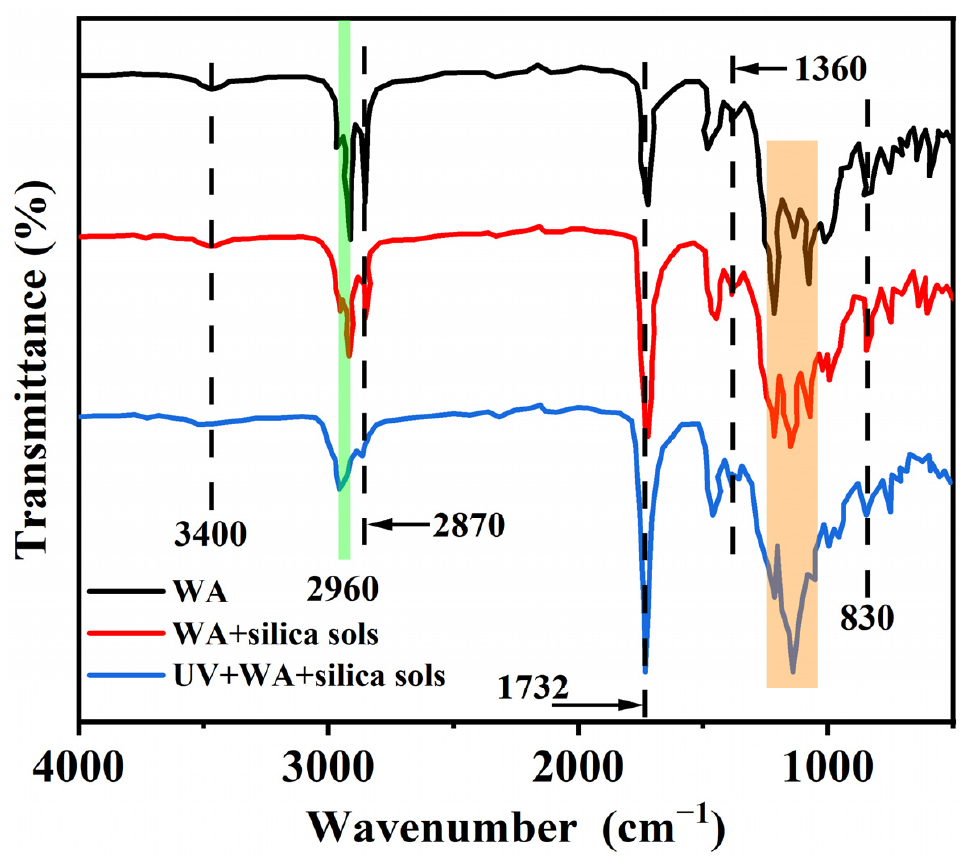
Figure 3. The FT-IR spectra of UV-curable WA before and after being reinforced by silica sol with a 2 wt% concentration.